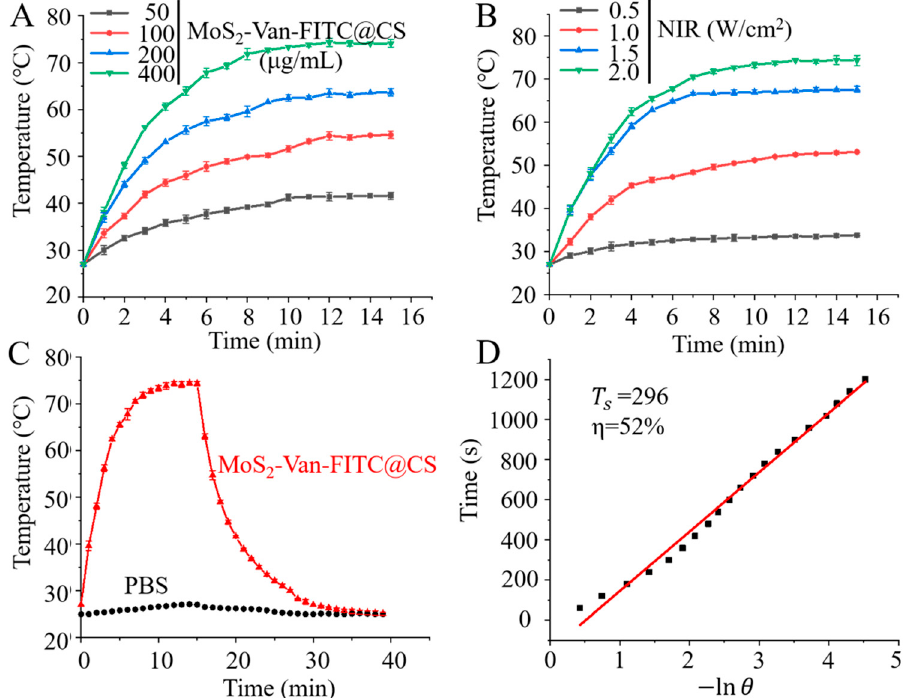
Figure 3. In vitro photothermal efficiency. ( A ) The photothermal responses of MoS 2 -Van-FITC@CS. Different concentrations (50, 100, 200 and 400 µ g/mL) were exposed to NIR irradiation (808 nm; 2 W/cm 2 ). PBS served as a control. ( B ) The photothermal responses of MoS 2 -Van-FITC@CS (400 µ g/mL), which was exposed to different power density of NIR irradiation (808 nm; 0.5, 1, 1.5 and 2 W/cm 2 ). ( C ) The heating and cooling curves of MoS 2 -Van-FITC@CS (400 µ g/mL) and PBS (laser irradiation at 808 nm). ( D ) The linear regression between the cooling period and − ln( θ ) of the driving force temperature. Results shown are mean ±SD, n = 3.